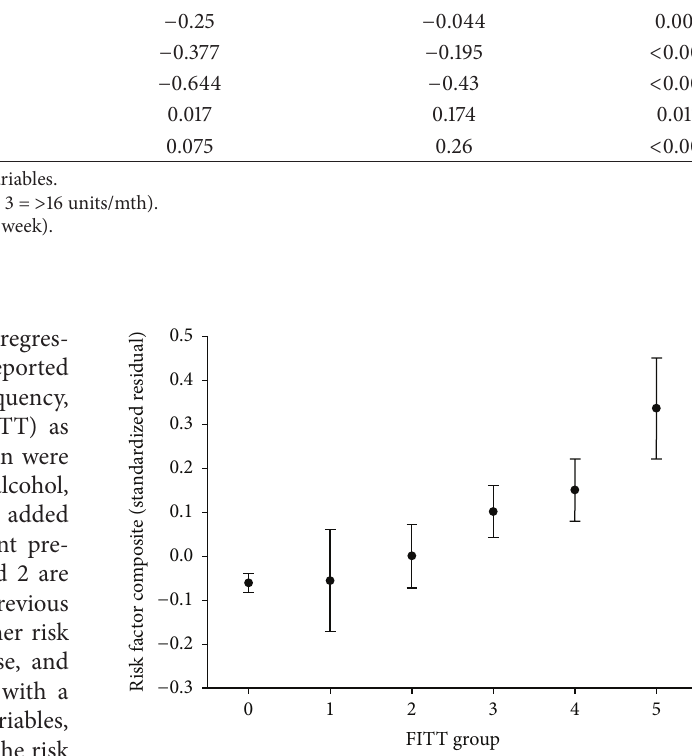
95% confidence interval Lower bound